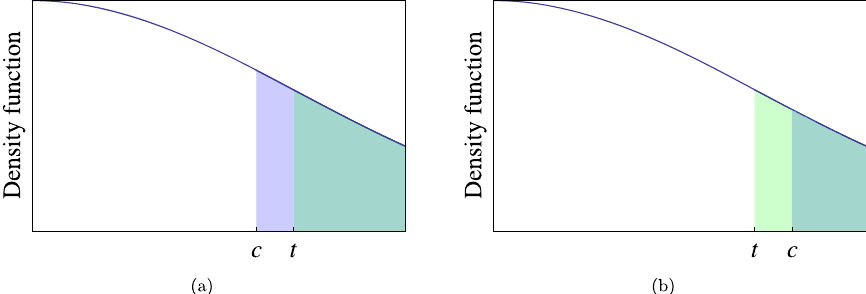
Fig. 2. In the plots above we see the density plot for the statistic T . As detailed in the main text we have performed an experiment for which the statistic T has value t (which can be seen in the plot), then the p -value for such a test is the green area (the area after t ). Now at the left side, we see an example where we have chosen a level of signi fi cance (the area of the blue region, which is the area after c ) greater than p , hence t is greater than our threshold value c . On the right we see an example where we have chosen a level of signi fi cance less than p , hence the value t is less than our threshold value c . Note that in some regions the two